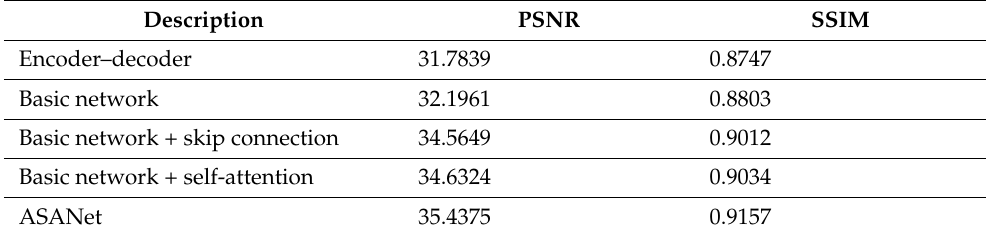
Table 2. Quantitative results for di ff erent network architecture.